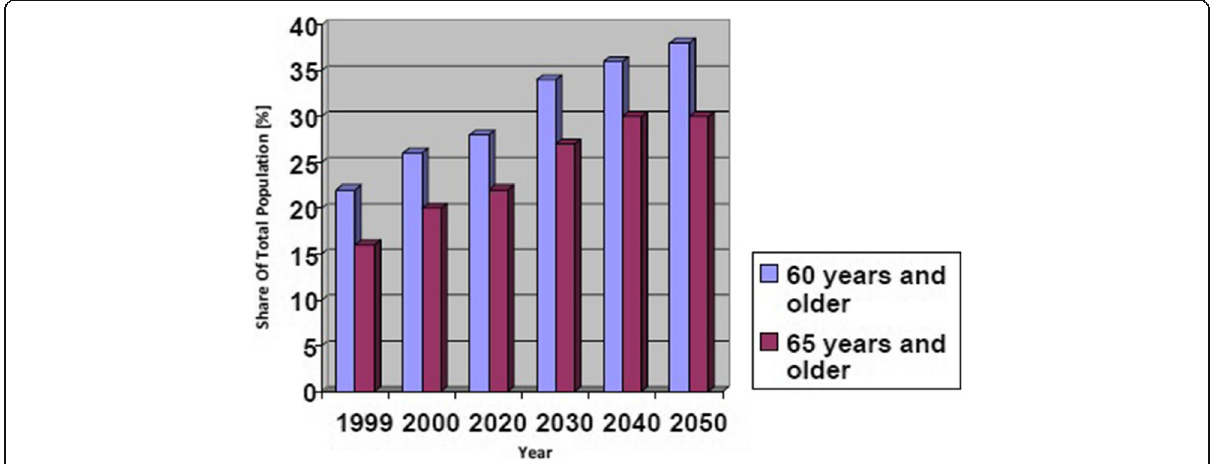
Fig. 1 Projected percentage of elderly people in German population. (Source: German Federal Bureau of Statistics